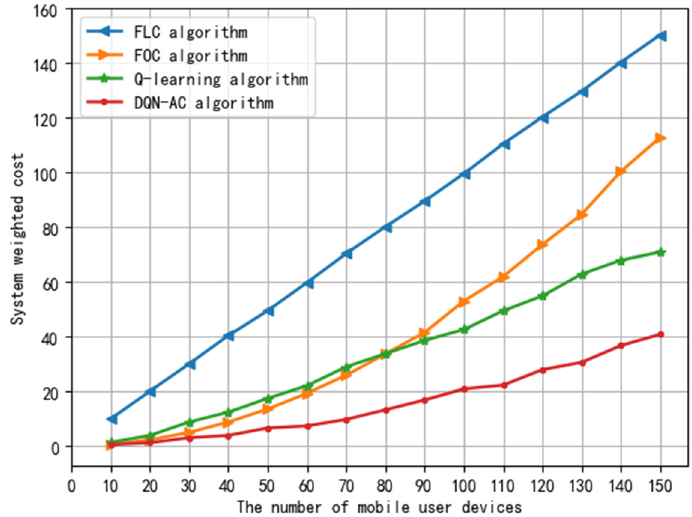
Figure 2. The impact of the number of mobile user devices on system weighted cost.